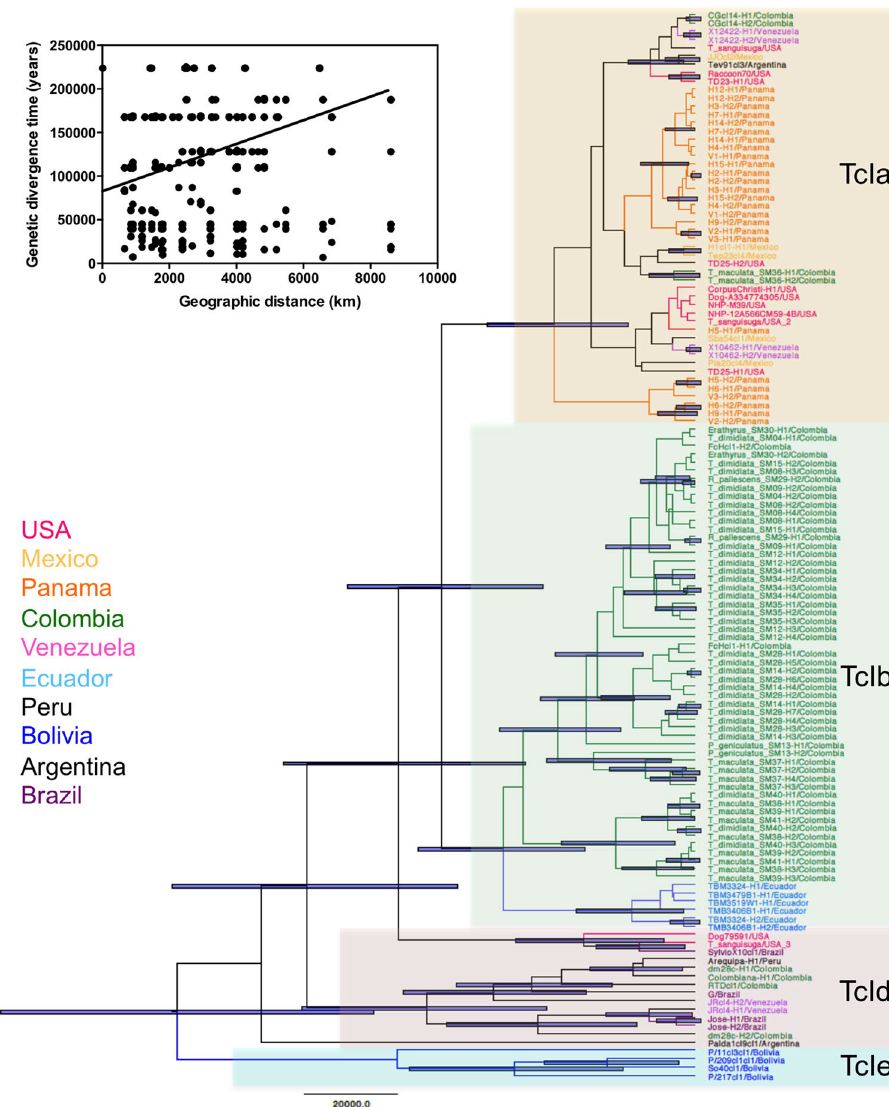
Figure 5. Phylogenetic analysis of TcI strains from northeastern Colombia. The best tree is shown based on Akaike information criteria, and T. cruzi sequences are color-coded according to their country of origin as indicated. The main TcI subgroups corresponding to TcIa, TcIb, TcId and TcIe are highlighted in different colors. Uncertainty in time of divergence is indicated for significant nodes (> 50% support). Insert: Mantel test indicating significant isolation by distance (R = 0.37, P =